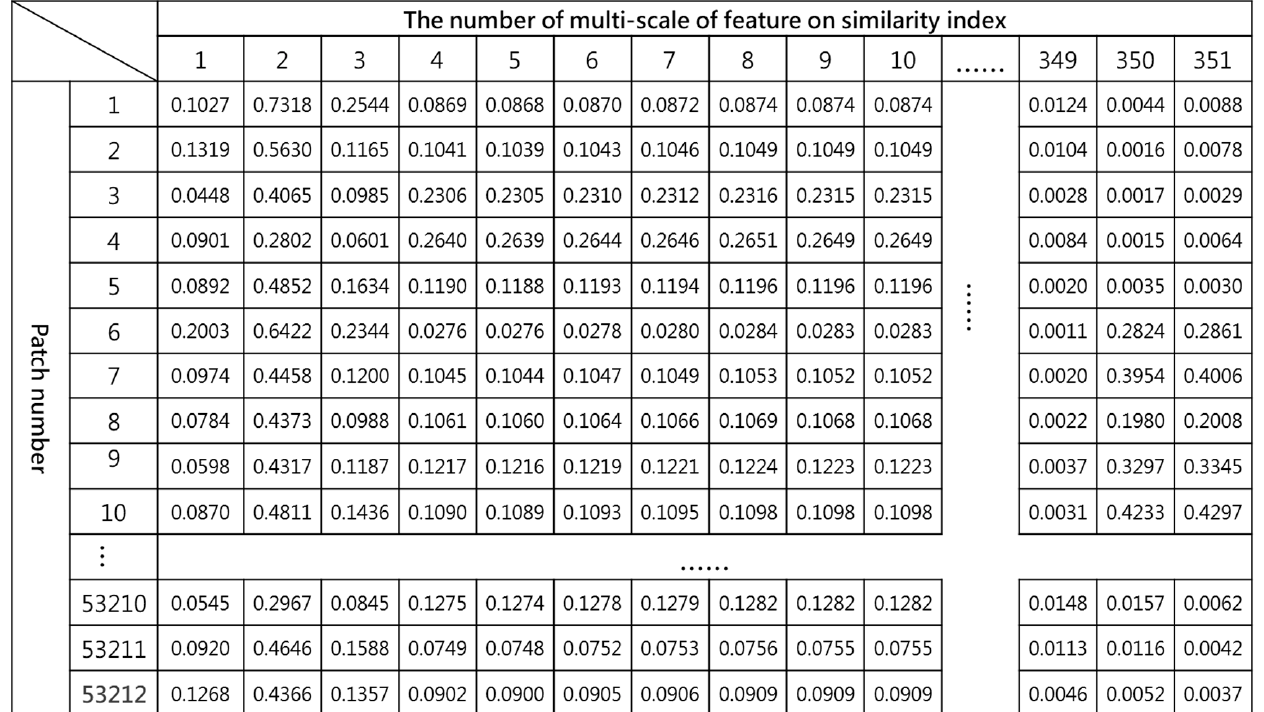
Table 6. The relations of patches and multi-scale of